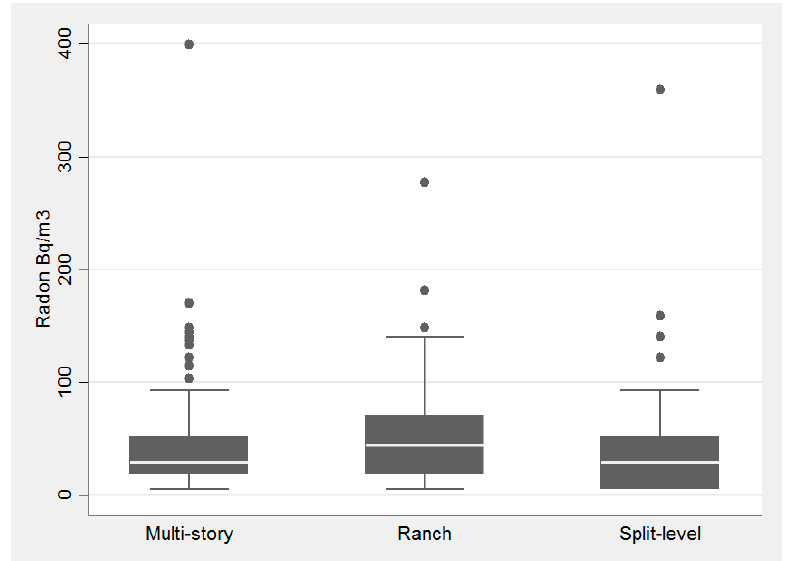
Figure 3. Association with housing type and radon concentration in the pilot study of homes tested in DeKalb County in 2015.